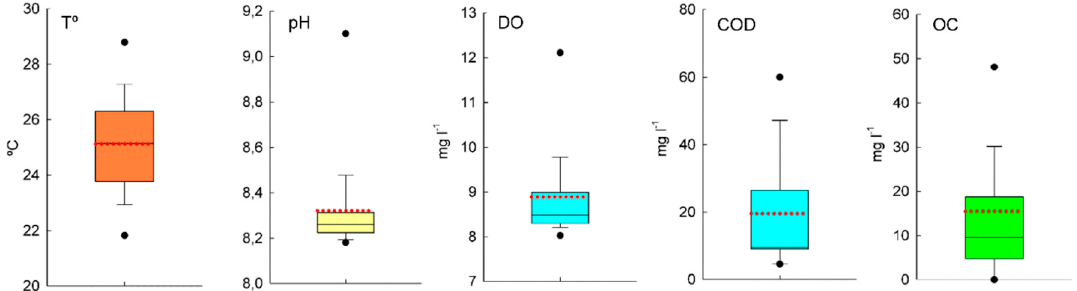
Figure 3. Physicochemical water parameters at different sample points (n = 43). T, Temperature; DO, dissolved oxygen; COD, chemical oxygen demand; OC, organic carbon.